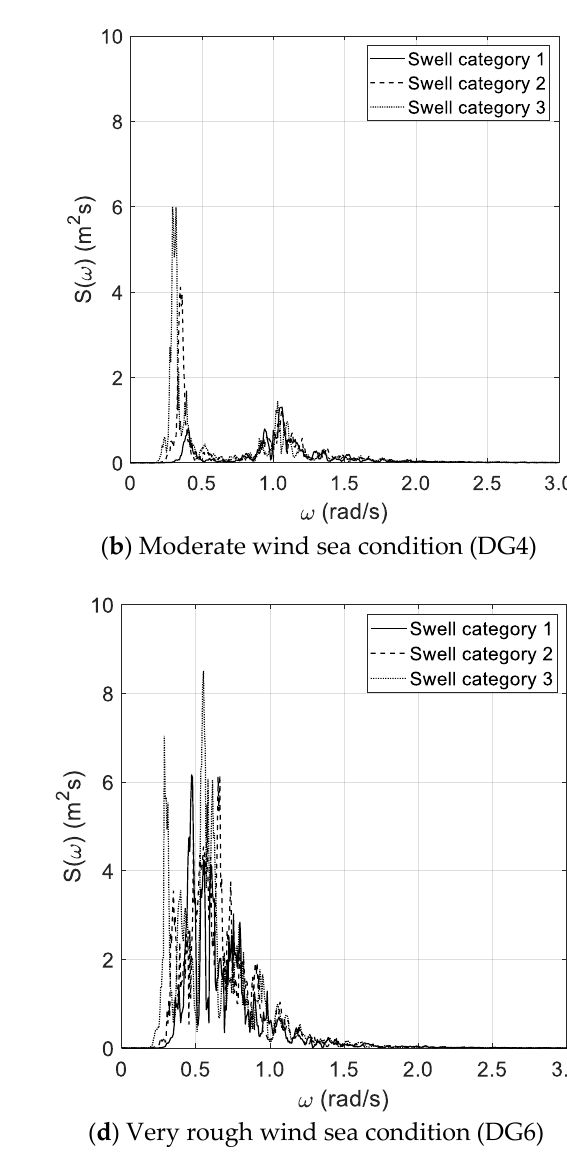
Figure 5. Spectral analysis (Thomson)—short duration with high frequency resolution.